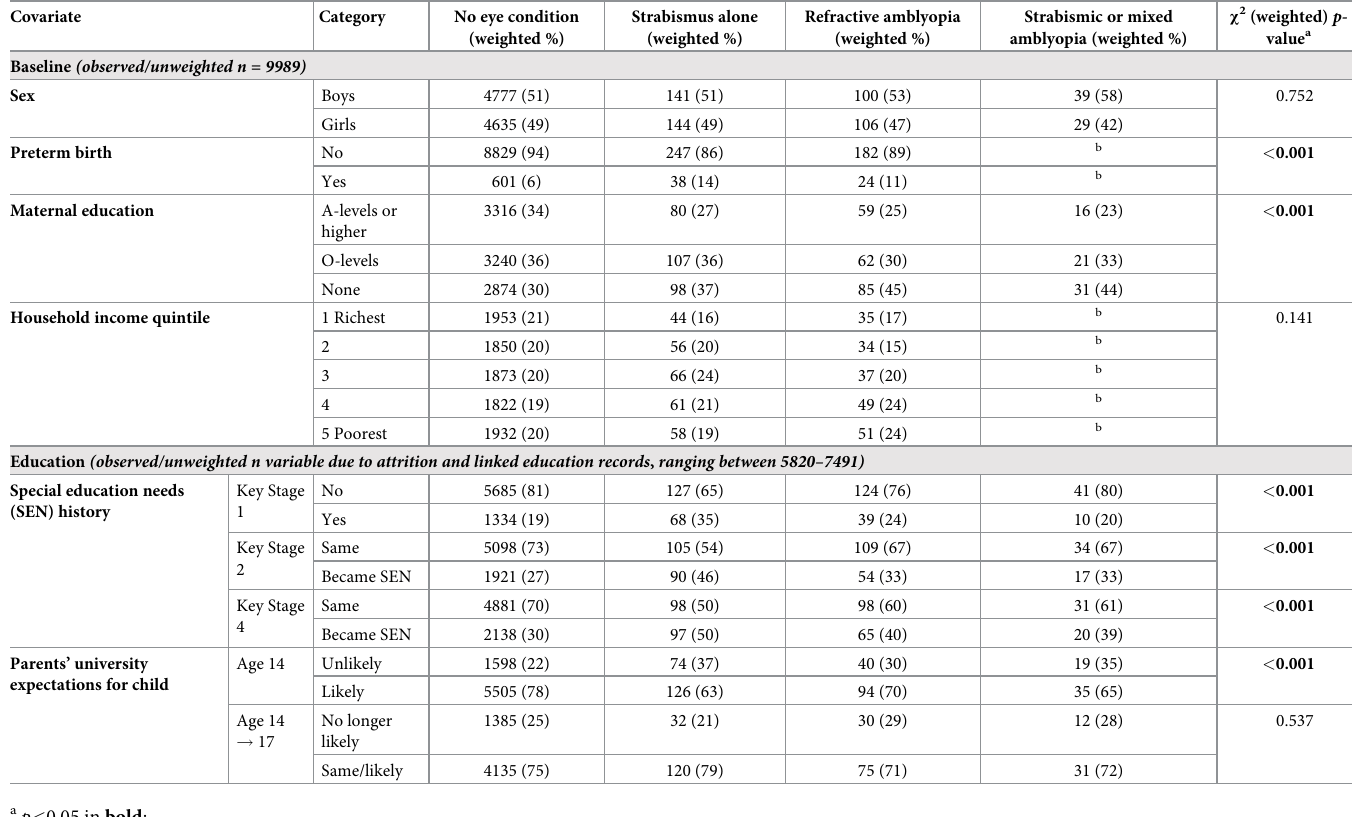
Table 2. Baseline and education characteristics of study population by history of amblyopia and/or strabismus at age 7 years. Covariate Category Strabismus alone